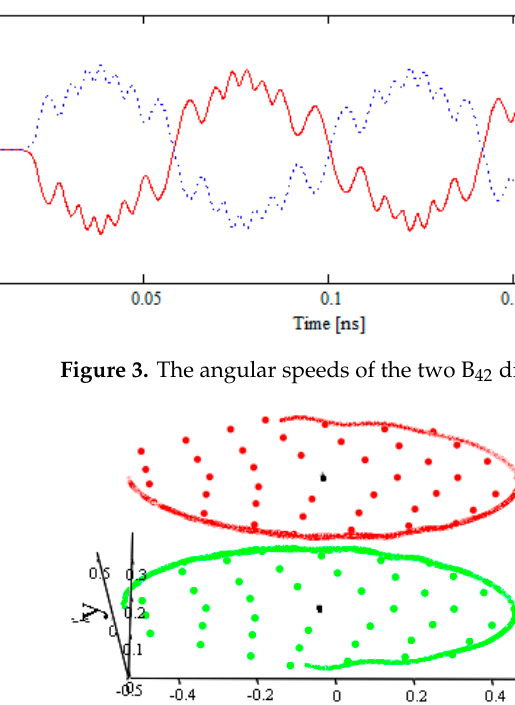
Figure 4. The trajectories of individual atoms belonging to different disks.